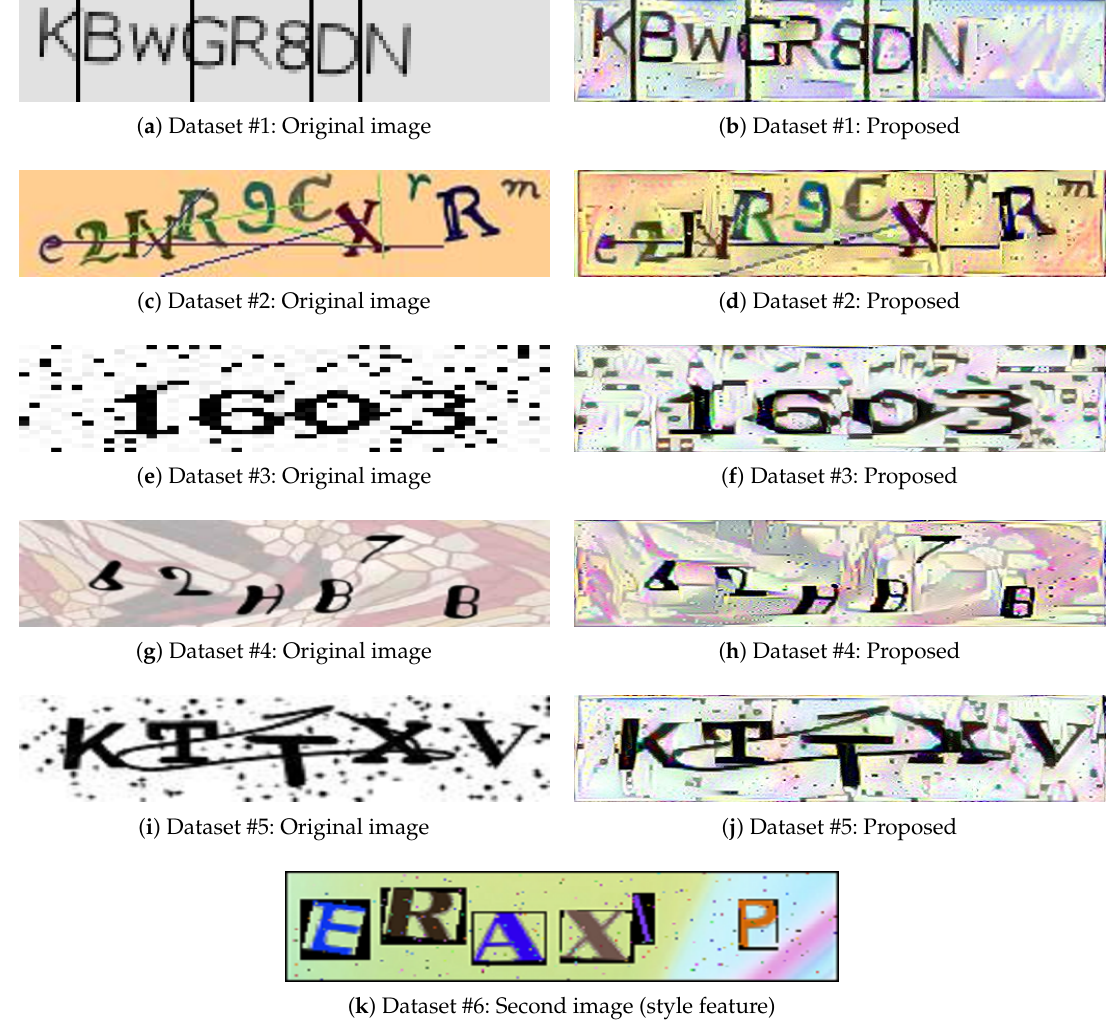
Figure 3. Examples of style-plugged CAPTCHAs formed using one style image. One original image from each dataset is shown, and an image from dataset #6 was used as the style image. “Proposed" is style-plugged